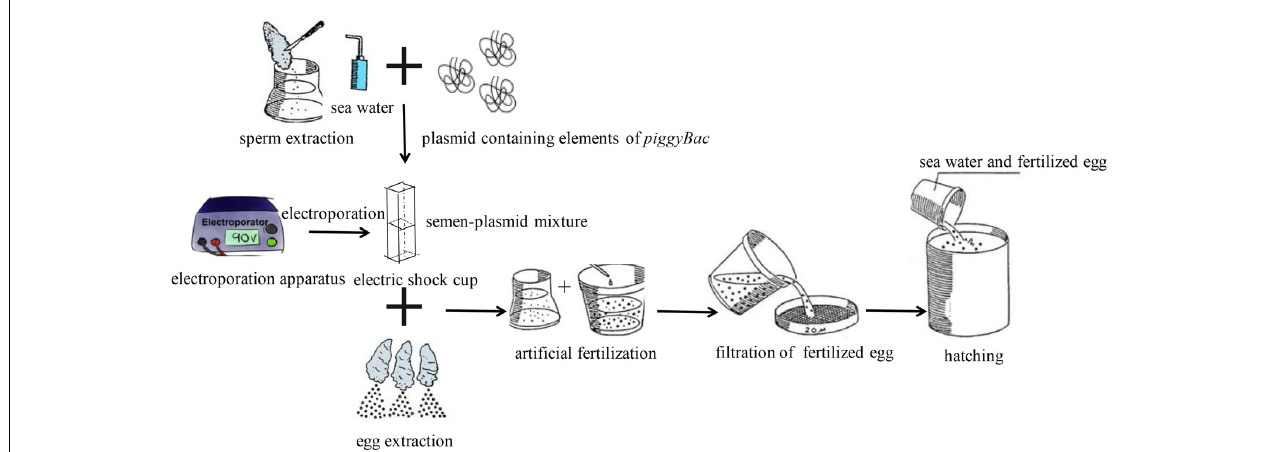
FIGURE 1 | Schematic diagram of procedures for transfection of piggyBac into Pacific